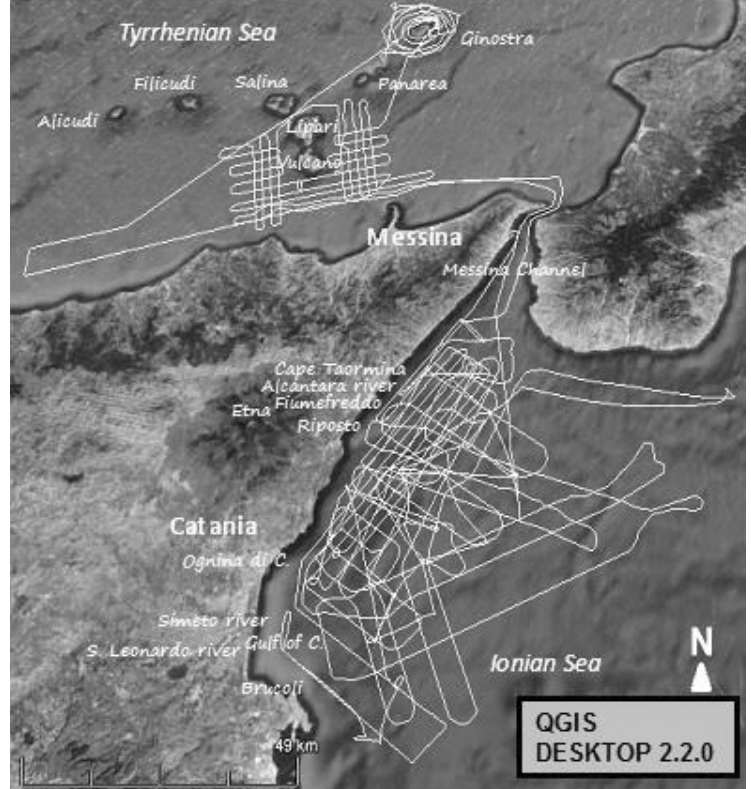
Figure 1. Map of the area under study with covered